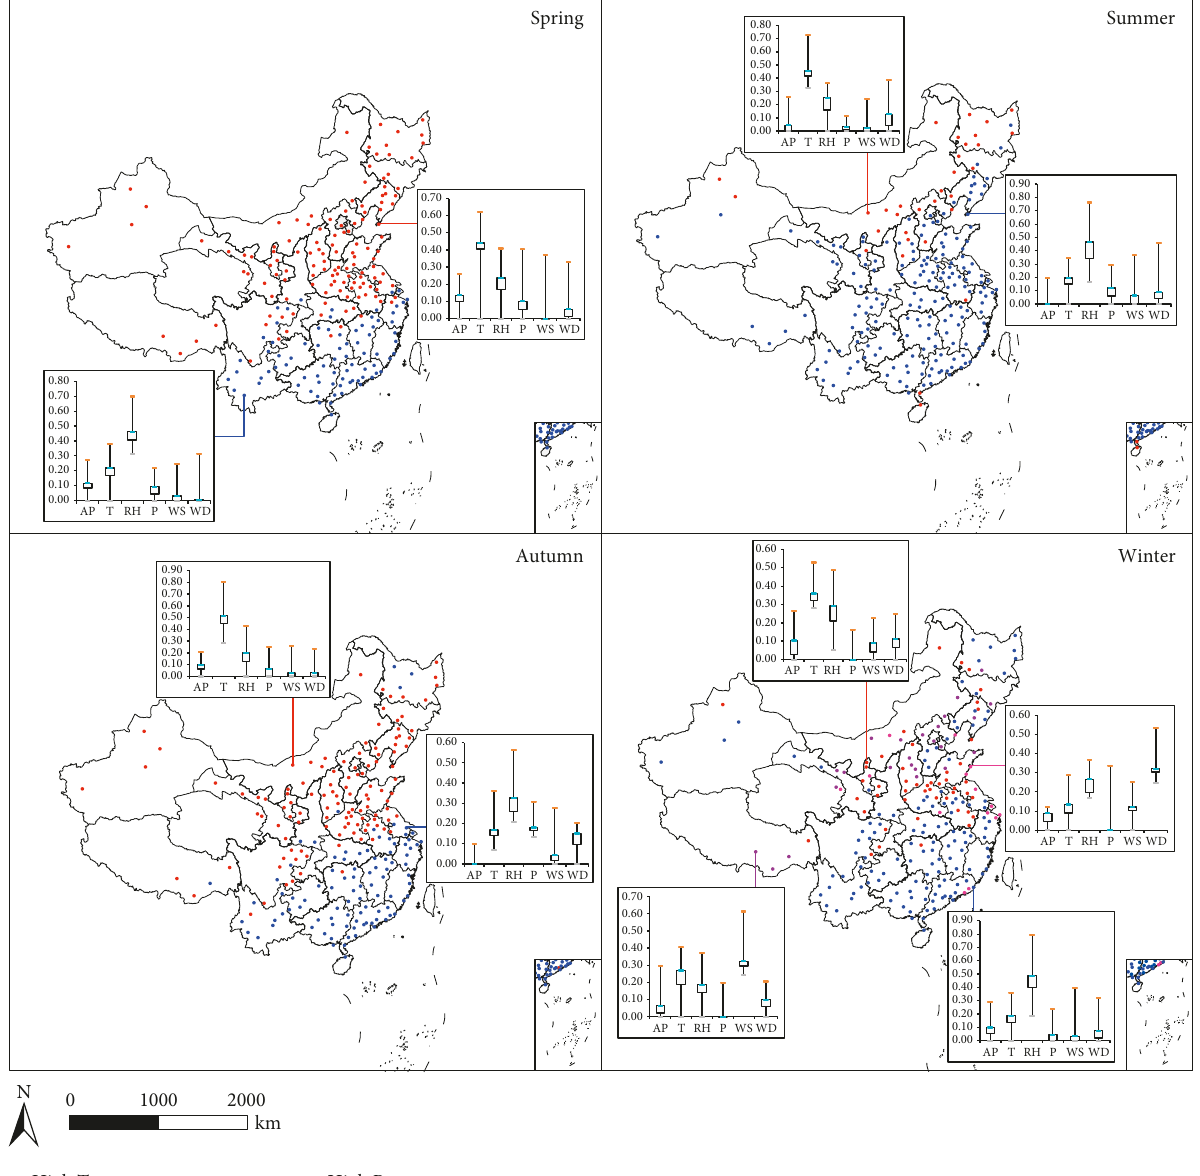
Figure 15: Relationship between O 3 concentration and meteorological